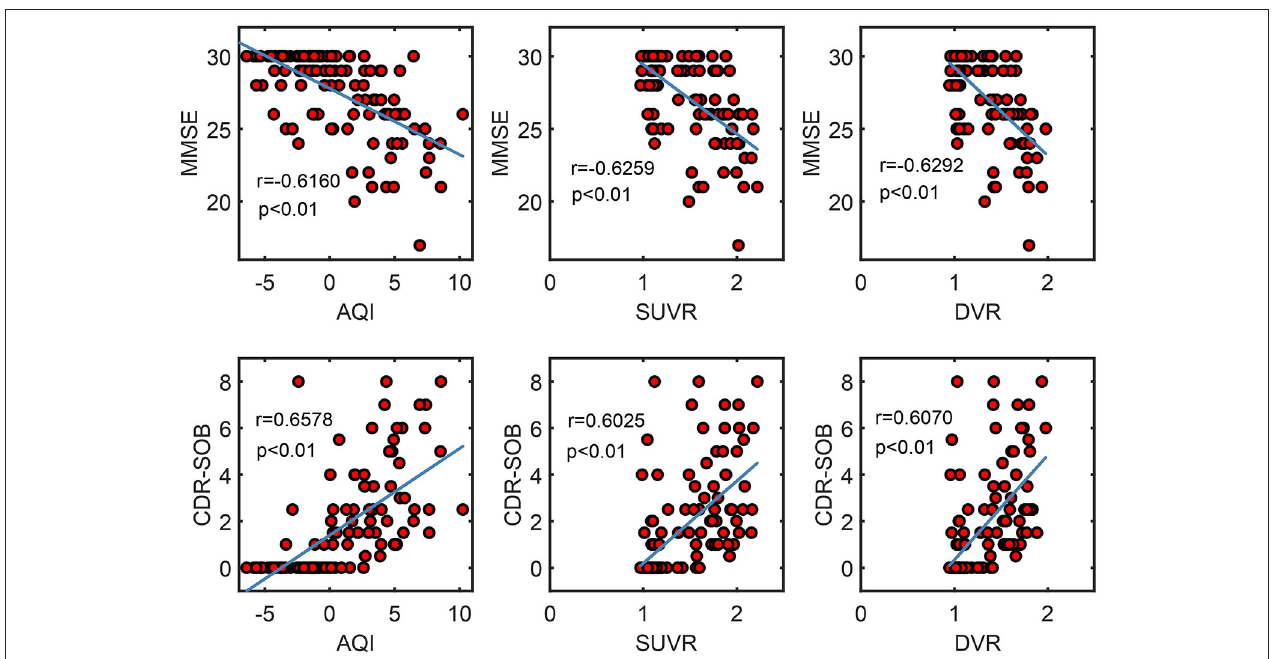
FIGURE 9 | Scatter plots show the correlation between measures (AQI/SUVR/DVR) and clinical scores (MMSE/CDR-SOB). Pearson correlation coefficient r and the corresponding p -value were reported for each pair of variables.